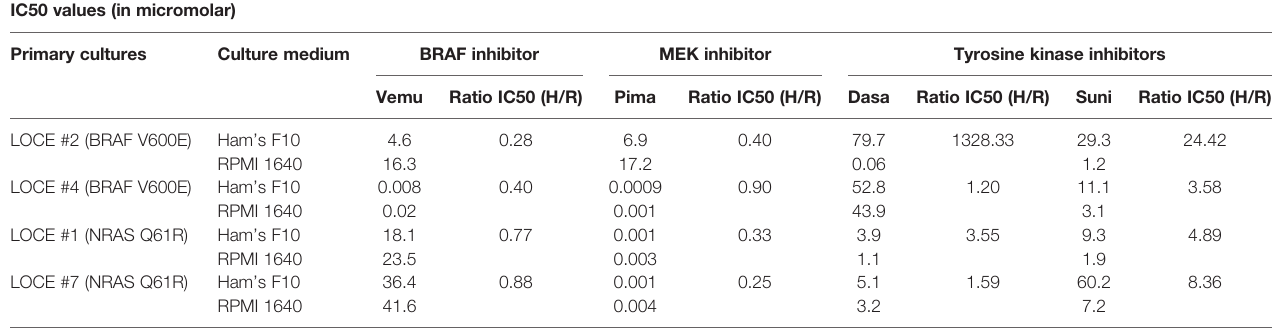
IC50 mean values and ratios (Ham ’ s F10 (H)/RPMI-1640 (R)) obtained with BRAF inhibitor (Vemurafenib), MEK inhibitor (Pimasertib), and TKI (Dasatinib, Sunitinib) in the four pigmented primary cultures (LOCE #1, LOCE #2, LOCE #4 and LOCE #7) (switchers group) established in the 2 culture media (Ham ’ s F10 and RPM 1640).